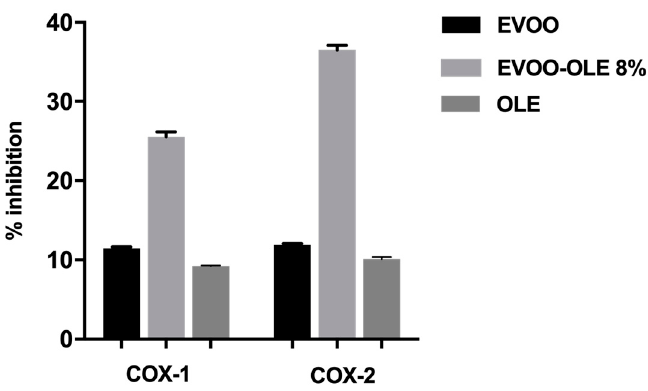
Figure 3. Anti-inflammatory effect at 225 µ g/mL of EVO and EVOO/OLE 8% extracts. The percentage of COX-1 inhibitory activity at 225 µ g/mL resulted of 11.5% for EVOO extract, 9.25% for OLE, and 25.5% for EVOO/OLE 8% (Figure 3). Likewise, the percentage of COX-2 inhibitory activity at 225 µ g/mL was 11.9% for EVOO extract, 10.1% for OLE, and 36.5% for EVOO/OLE 8%.